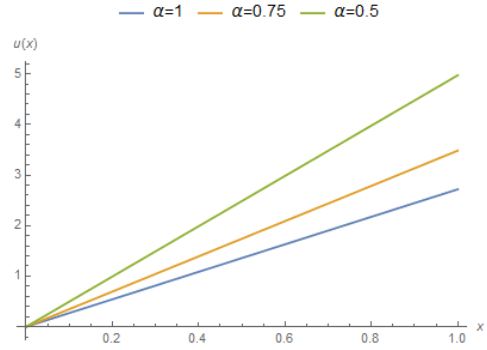
Figure4: Absolute error of example3 at Figure 14. Absolute error of Example 3 at α = 1. (cid:11) = 1